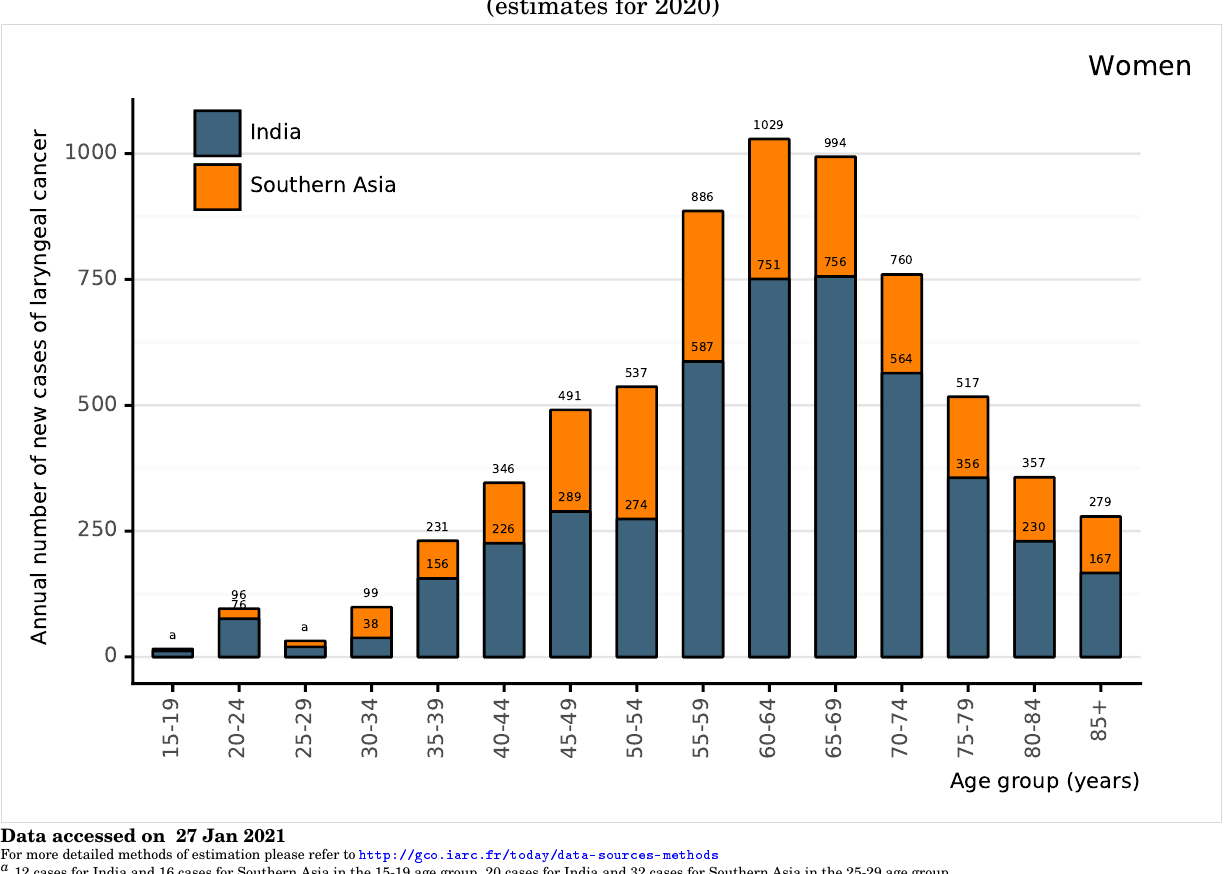
Figure 102: Annual number of new cases of laryngeal cancer among women by age group in